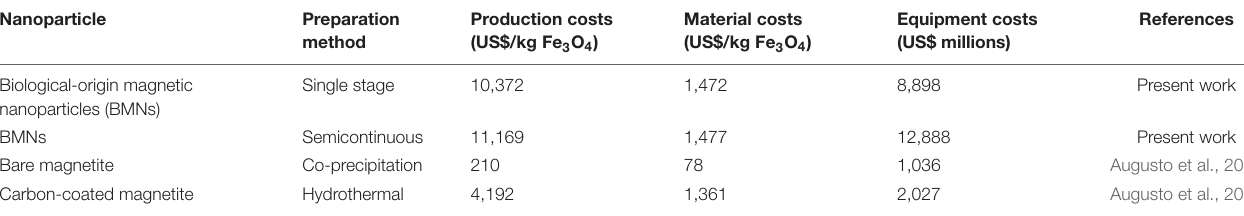
FIGURE 7 | Comparison between production costs (left of dashed vertical line) and market selling prices (right of vertical dashed line) of BMNs and chemically manufactured magnetite nanoparticles, with and without coating. For BMNs, we considered MSPs for market prices. For commercial magnetic nanoparticles, we considered production prices reported by Augusto et al. (2020). For details on the characteristics and suppliers of commercial magnetic nanoparticles, please refer to Supplementary Table 11 . TABLE 4 | Comparison between production costs for biogenic and synthetic magnetic